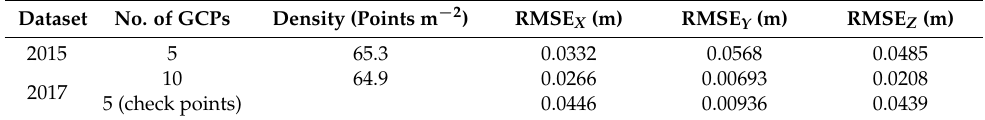
Table 2. Properties and planimetric and altimetric accuracy of the point clouds derived from the RGB imagery by using